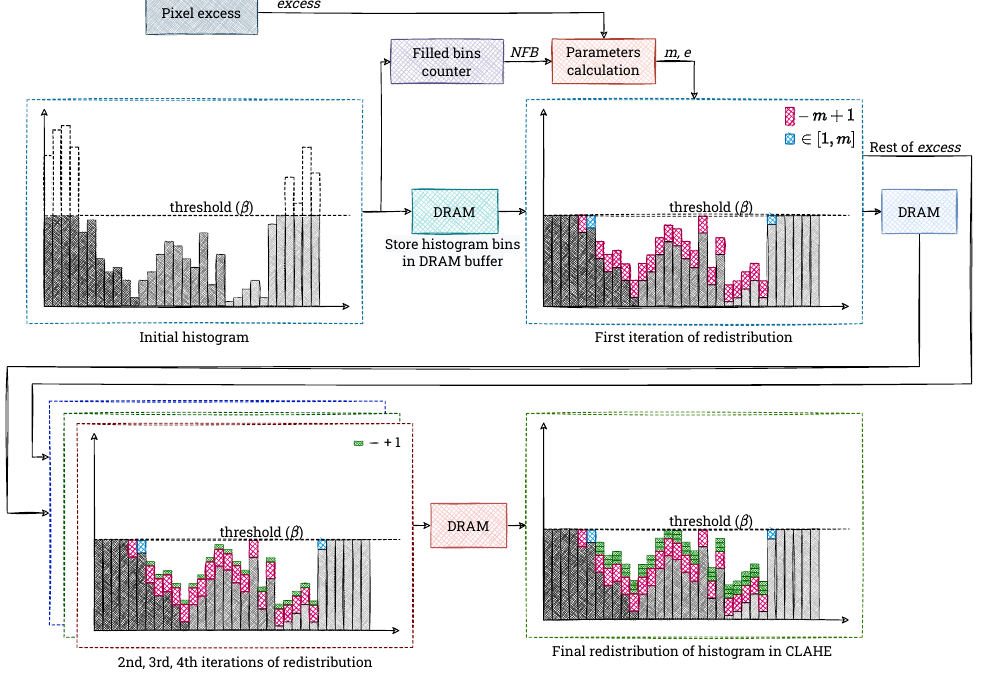
Figure 12. Scheme of the implementation of the redistribution process. We read the input histogram sequentially (bin after bin), count the bins filled to the limit β , and combine this value together with the input excess to calculate m (average excess) and e (residual). The input histogram is then stored in the DRAM buffer. After calculating the mentioned parameters, we read the histogram from the DRAM buffer and perform the first iteration of the redistribution, in which we try to add m + 1 to each bin. If it is not possible, we fill the bin to the limit β and accordingly modify the value of e . The resulting histogram is stored in another DRAM buffer. After that, we perform the next 3 iterations, this time adding only 1 pixel to each bin (thus decreasing the value of e ), where it is possible. Between each iteration there are also DRAM buffers (not present in the diagram for clarity). In this way, we finally obtain a redistributed